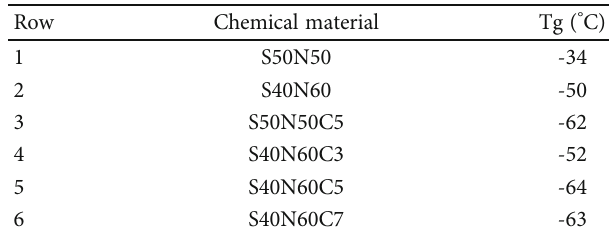
Table 7: Glass transition temperature (Tg) of samples.